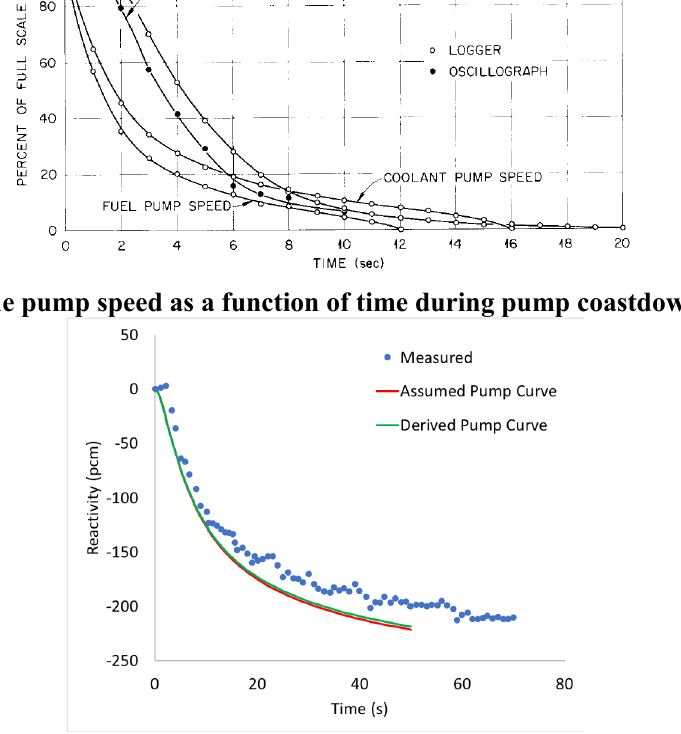
Figure 7. SAM results vs experimental measurements for the pump coastdown